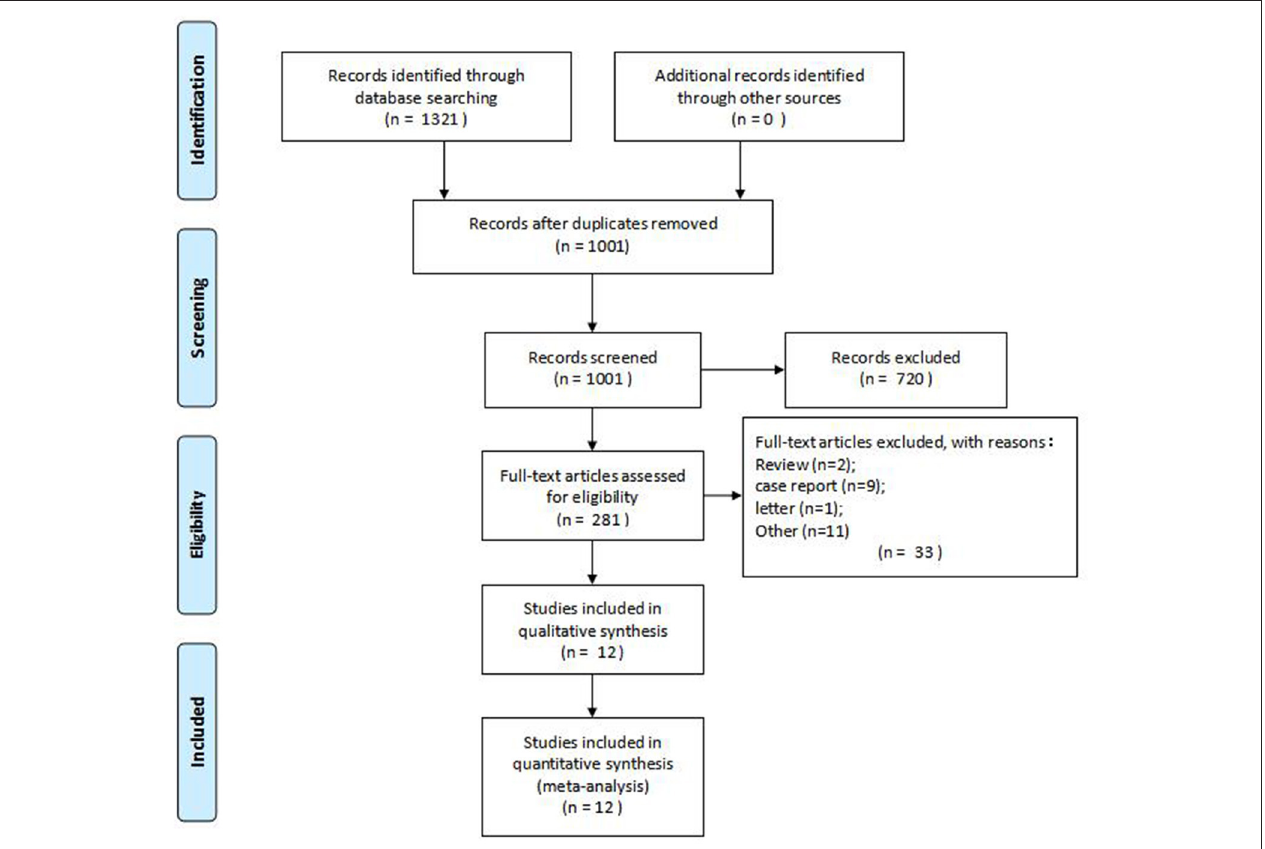
FIGURE 1 | PRISMA flow diagram of study